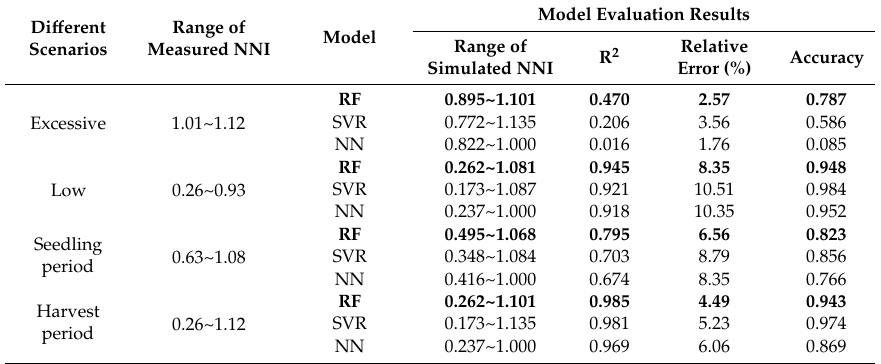
Table 5. Model evaluation result under different plant N nutrition status and growth stages.